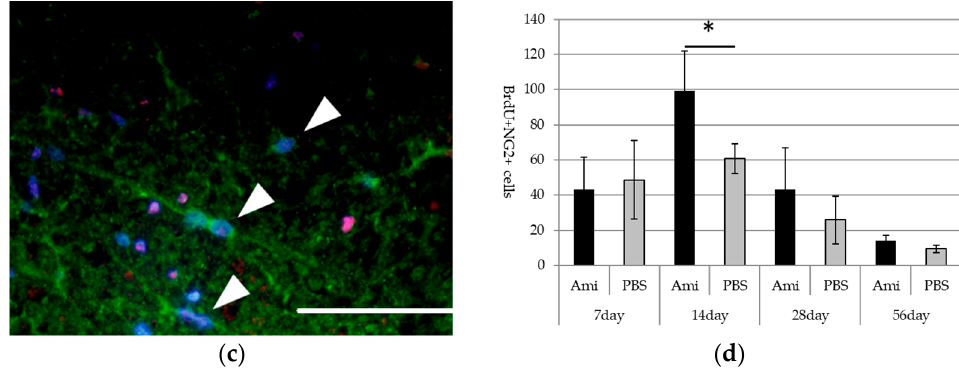
Figure 3. ( a – c ) Double immunostaining of the dorsal funiculus from the amiloride group at day 14 for BrdU (red) and NG2 (green) with 4 ′ ,6-diamidino-2-phenylindole (DAPI) nuclear counterstaining (blue). The arrowheads indicate the BrdU- and NG2-positive cells (scale bars 50 µm); ( d ) In both the amiloride and PBS groups, an increase of BrdU- and NG2-positive cells was observed at day 14, followed by a decrease to day 56. Significantly more BrdU- and NG2-positive cells were observed in the amiloride group compared to the PBS group on day 14. The asterisk indicates significant difference between the amiloride and PBS groups with a Mann–Whitney U test (* p < 0.05, n = 5 per group, error bars are standard deviations).